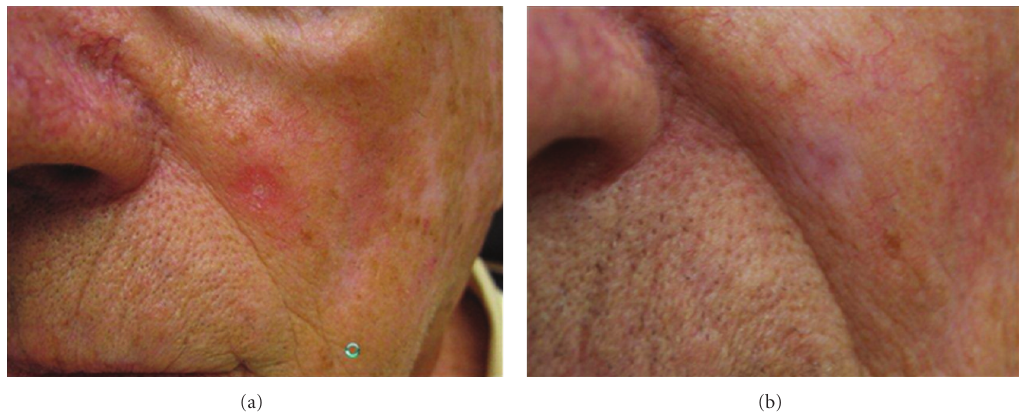
Figure 4: BCC on the left cheek, before and three months after PDL treatment. Complete resolution of the